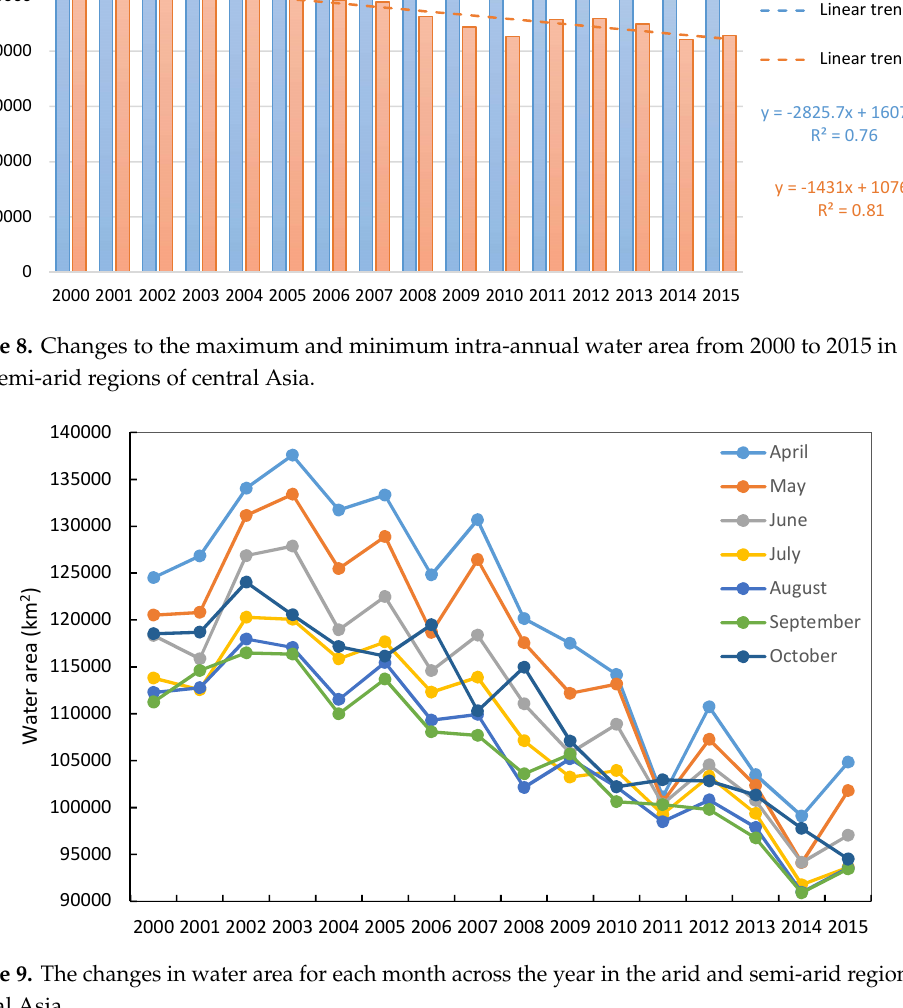
Figure 8. Changes to the maximum and minimum intra-annual water area from 2000 to 2015 in arid and semi-arid regions of central Asia.